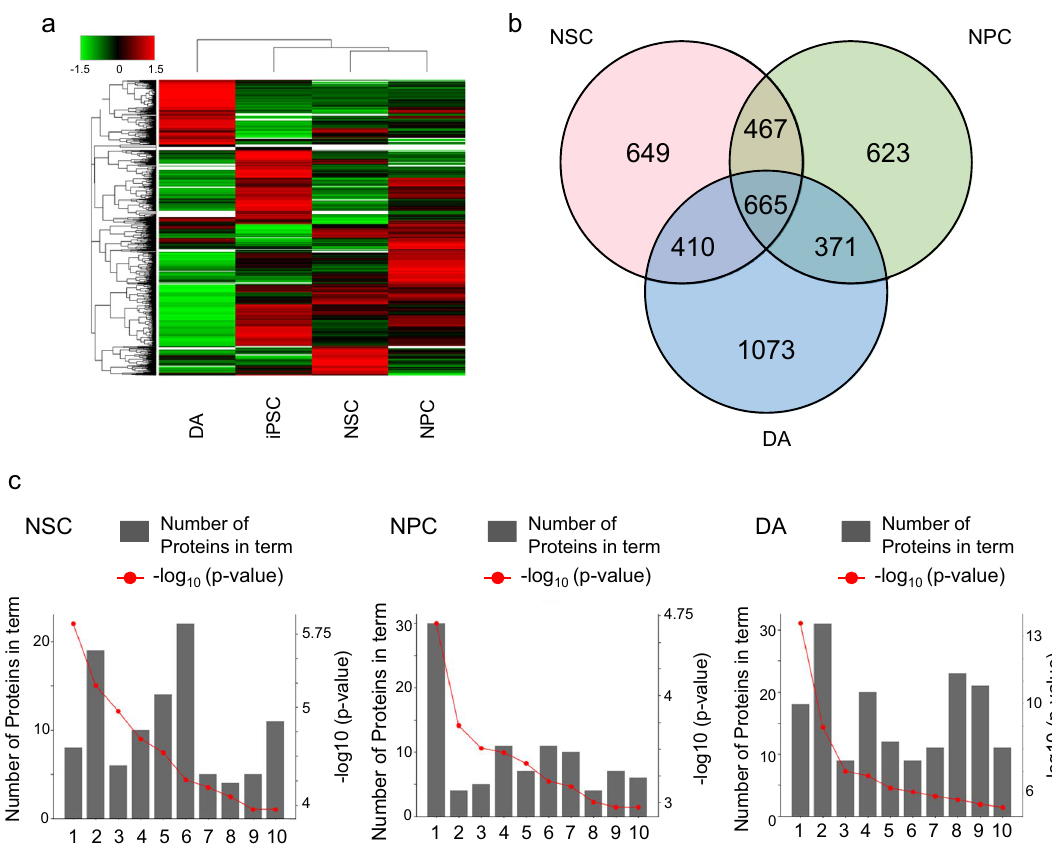
Figure 3. Proteomic datasets of all the proteins in the iPSCs, NSCs, NPCs, and DAs. ( a ) The heat map of all the identified proteins in the iPSCs, NSCs, NPCs, and DAs. ( b ) The Venn diagrams of proteins with increased levels in the NSCs, NPCs, and DAs compared to the iPSCs ( p -value < 0.05). ( c ) GO enrichment analysis of the proteins with increased levels in the NSCs (left), NPCs (middle), and DAs (right) compared to the iPSCs ( p -value < 0.05). Left: 1. glutathione derivative biosynthetic process, 2. brain development, 3. semaphorin-plexin signaling pathway involved in axon guidance, 4. glutathione metabolic process, 5. branchiomotor neuron axon guidance, 6. central nervous system development, 7. nitrobenzene metabolic process, 8. axon development, 9. regulation of cardiac muscle contraction by regulation of the release of sequestered calcium ion, 10. nervous system development. Middle: 1. cell adhesion, 2. mesenchyme migration, 3. protein localization to synapse, 4. dendrite morphogenesis, 5. muscle contraction, 6. fatty acid beta-oxidation, 7. integrin-mediated signaling 4. axon guidance, 5. chemical synaptic transmission, 6. glutamate secretion, 7. regulation of cardiac conduction, 8. learning, 9. ion transmembrane transport, 10. synapse